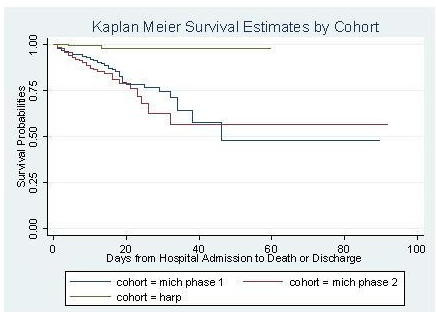
Unadjusted Survival Curves Comparing Three Patient Cohorts from the Same Hospitals during Index Hospitalization.